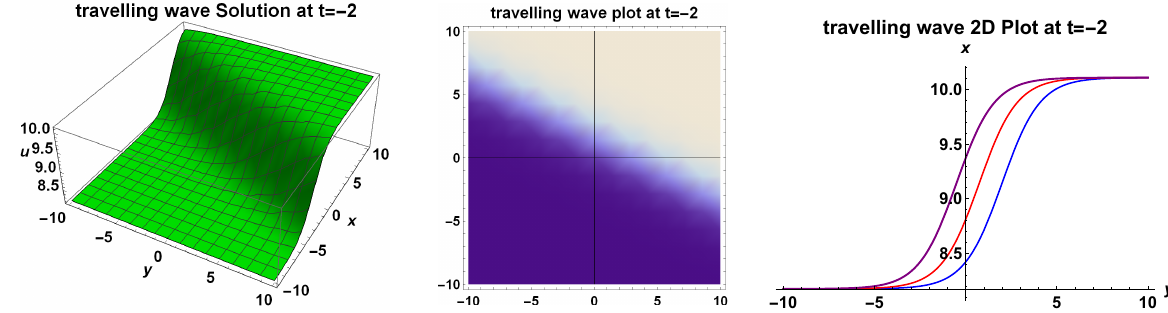
Figure 25. Tavelling wave profile depiction of nontrivial solution (113) at t = − 2.